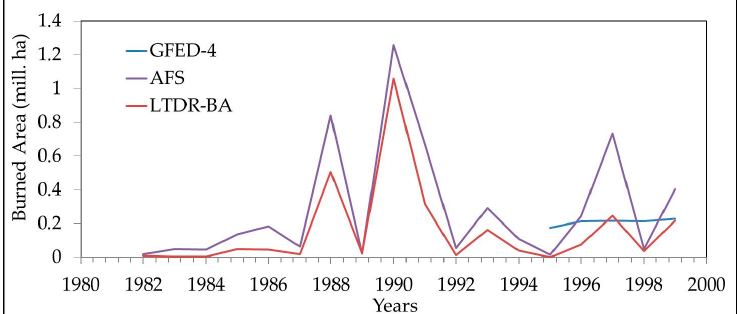
Figure 7. 1982–2015 annual Alaskan BA from GFED-4 and LTDR BA products in comparison to the Alaskan Fire Service (AFS) database.